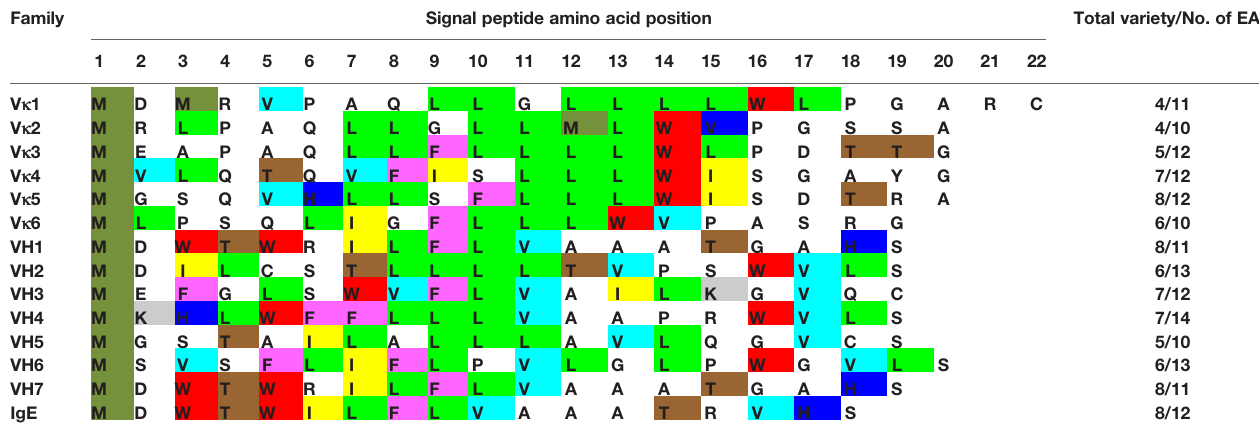
TABLE 1 | List of SP sequences with essential amino acids (EAAs, various colors) and non-essential amino acids (NEAAs, uncoloured) usage shown. Family Signal peptide amino acid